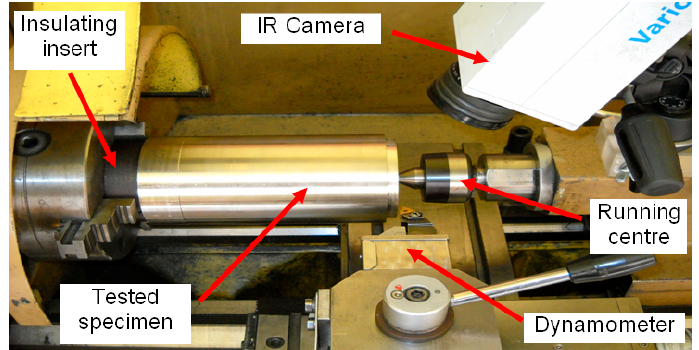
Figure 1. View of the sample in the machining space of the test bench [6].